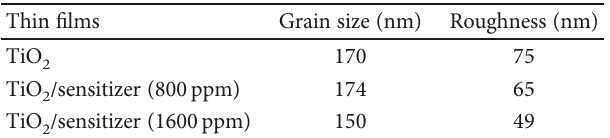
Table 4: Roughness and grain size of TiO fi lms. Thin fi lms Grain size (nm)